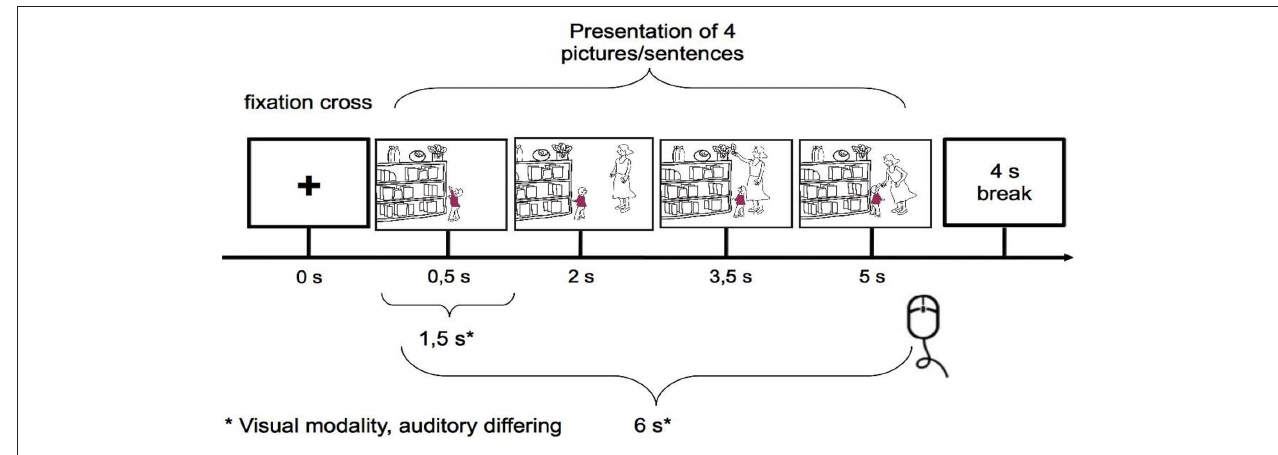
W. B. Gratzer, Med. Res. Council Labs, Holly Hill, London), and a photon differential path-length factor of 5.98 cm for 830 nm and 7.15 for 760 nm. The obtained time series of [oxy-Hb] and [deoxy-Hb] concentration changes were low-pass